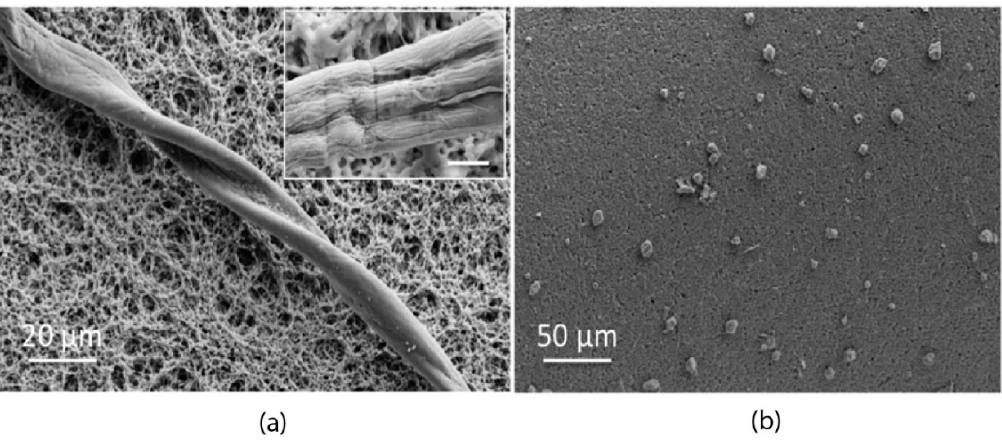
Figure 6. SEM images of porphyrin 7 self-aggregated in DMAC / H 2 O (58 / 42, v : v ): c = 3.0 µ M (( a ), inset: enlargement of a structure obtained under the same conditions, scale bar 5 µ m): ( b ) c = 10 µ M. Adapted with permission from [41]. Copyright 2014, The Royal Society of Chemistry Chiral mesoscopic structures based on tetrasteroidal porphyrin derivative 8 and 9 differing by the number of OH groups placed at the steroid rings (Scheme 2), have been also recently obtained by strategy in interfacial nanoarchitectonics [61]. An effective transfer of chiral information from the porphyrin units to the suprastructures was here achieved at the air/water interface under increasing surface pressure conditions for both derivatives, with distinctive implications depending on their different amphiphilic character, modulated by the number of hydroxy groups in the steroid units. Interesting insights on the molecular organization of the two porphyrin LB films deposited on hydrophilic quartz surface were revealed by CD measurements. Indeed, a specular shape of the 8 (+/ − ) and 9 ( − /+) dichroic bands was observed, with almost the same intensity, indicating the formation of porphyrin-based helical suprastructures of similar size, but opposite chirality.